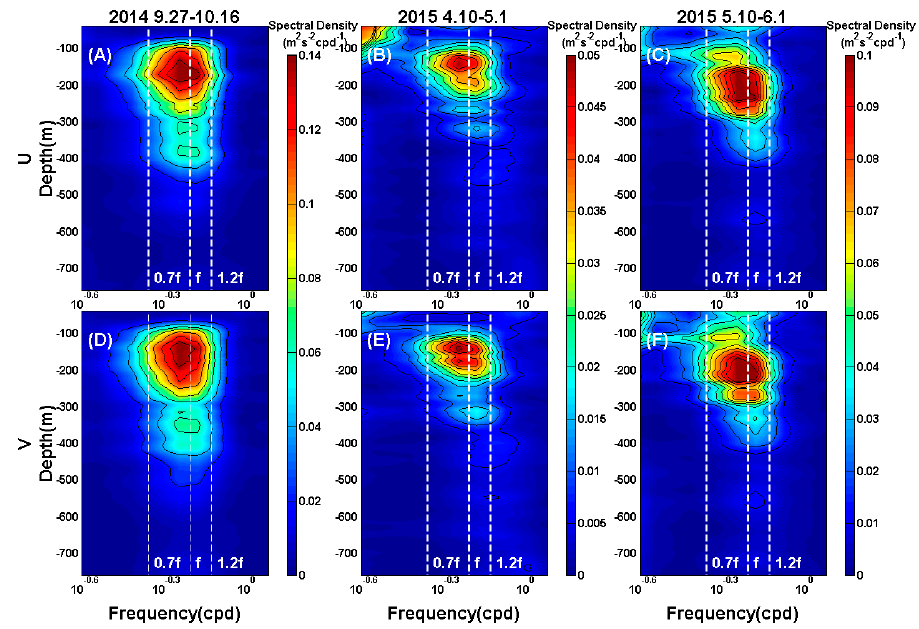
Figure 2. The power spectra of the first near-inertial oscillation (NIO) event is shown in ( A , D ). The second is shown in ( B , E ). The third is shown in ( C , F ). The horizontal axis of the figure is frequency with the unit cpd. The vertical axis is water depth with the unit m. Power spectra of the ( A – C ) eastward and ( D – F ) northward components of the horizontal currents at 40–800 m deep for the three NIOs. The dashed lines indicate local frequencies f , 0.7 f , and 1.2 f . Note that the different color-bars represent the three typhoon events.